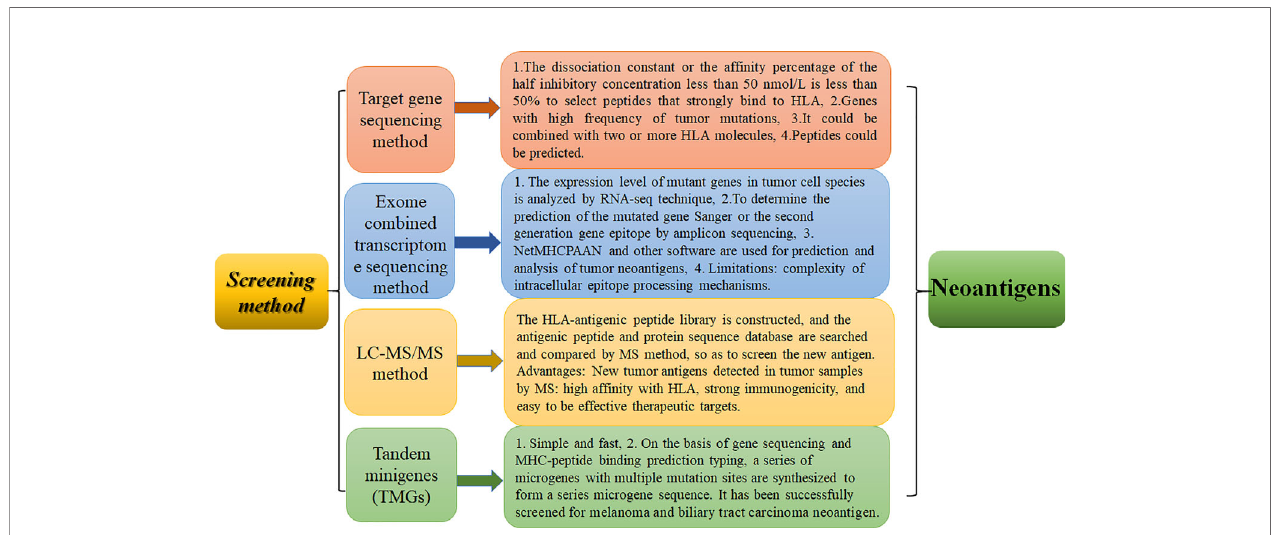
FIGURE 1 | Screening methods of neoantigen identi fi cation and their advantages and disadvantages. The advantages and disadvantages of four methods, including serological analysis of recombinant expression cDNA clones, exome combined transcriptome sequencing method, LC-MS/MS method, and tandem microgenre method, are